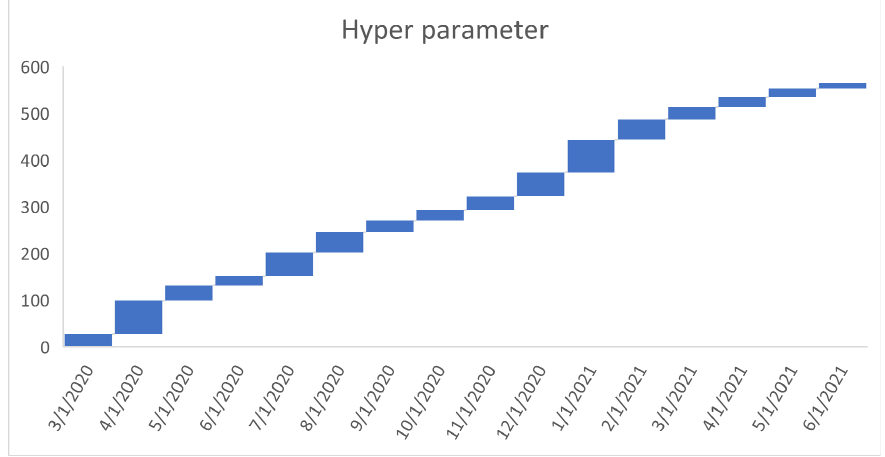
Figure 8. Progressive hyperparameter in US. For readability, note that 4/1/2020 refers 1 April 2020.